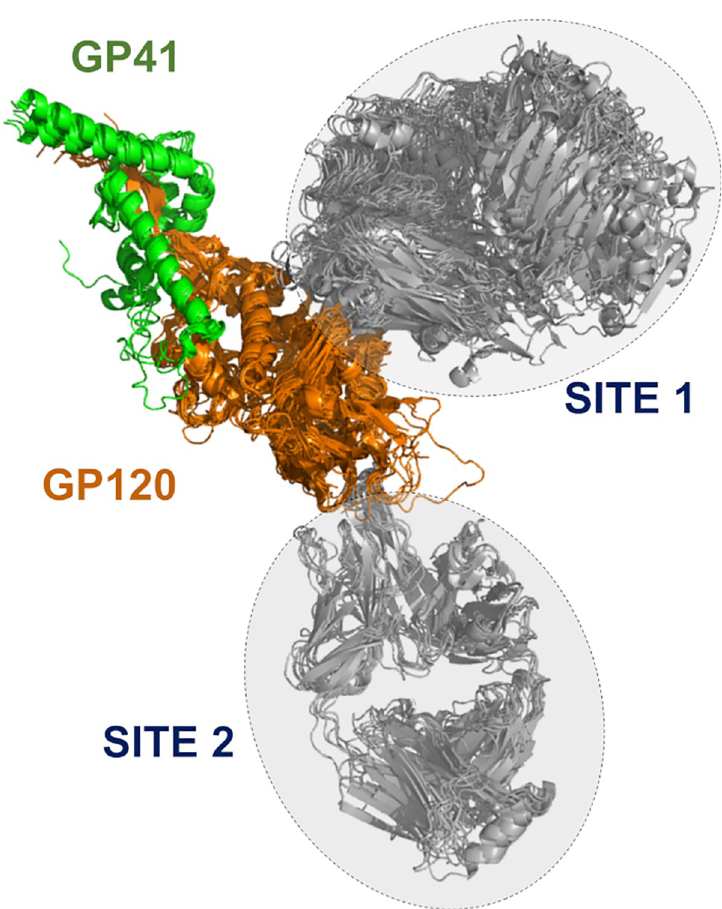
Fig 7. Antibody recognition sites in HIV GP120/GP41. Two main Ab binding regions based on the structural complex of the Ebola surface glycoprotein GP120/GP41 proteins with anti-HIV-1 Abs. Site 1 encompasses a structural overlay of 18 different site-specific Abs, whereas Site 2 contains 10 different